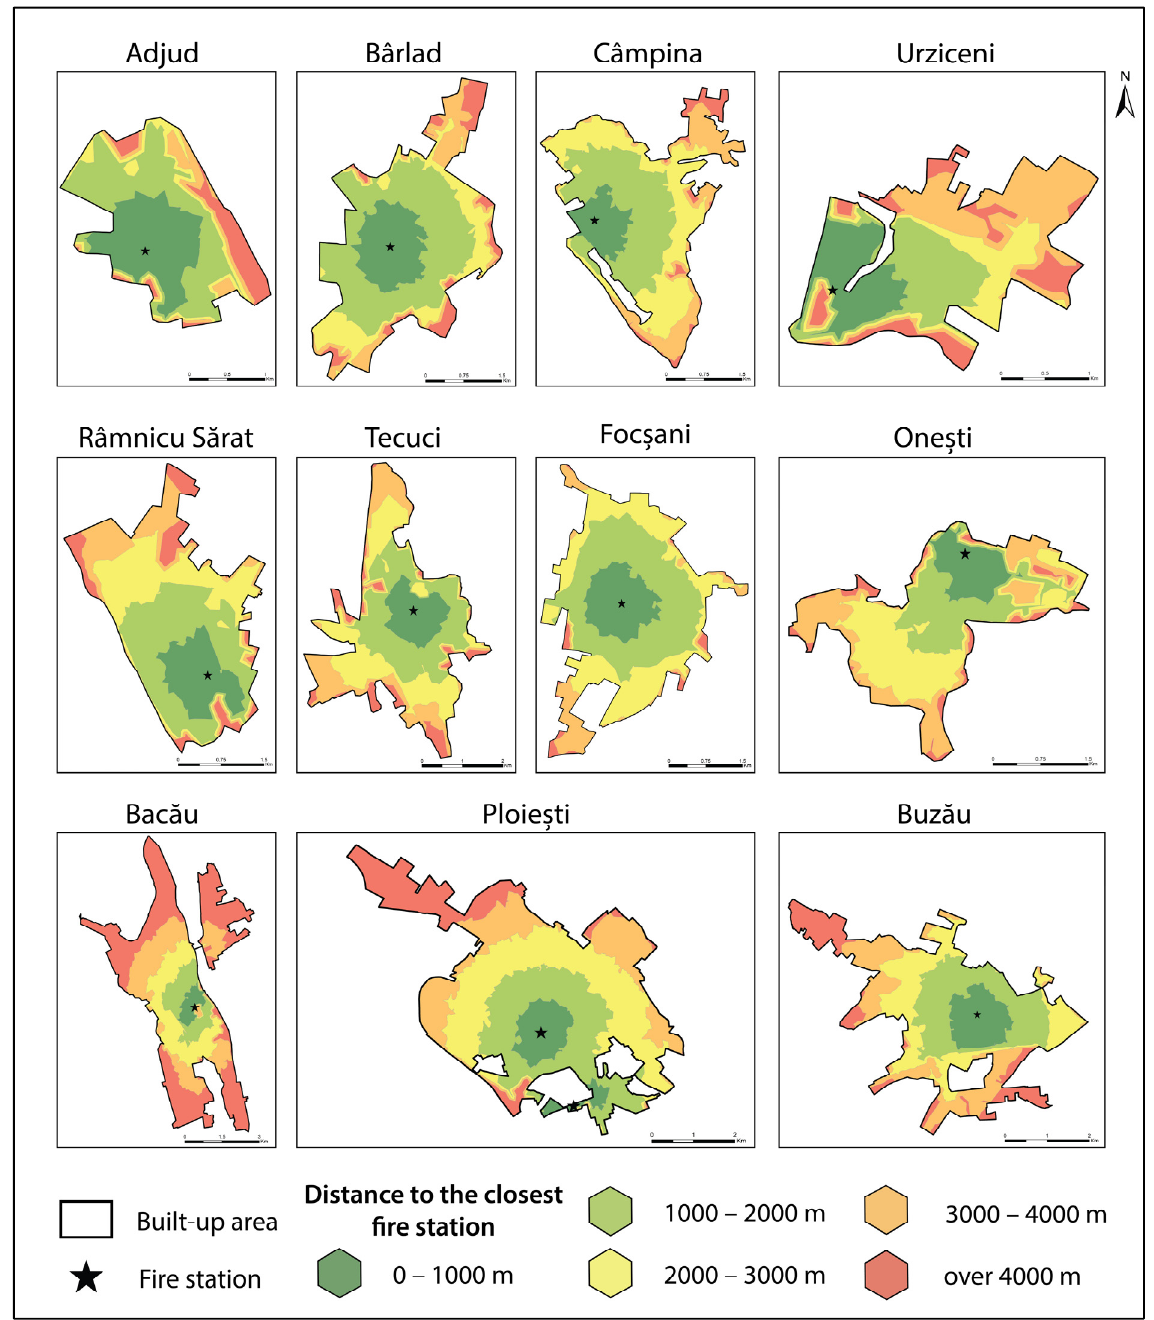
Figure 6. The service areas of the fire stations in the 11 urban settlements. Service areas extend away from fire stations. The scale was adapted for each urban settlement to better portray the service areas.